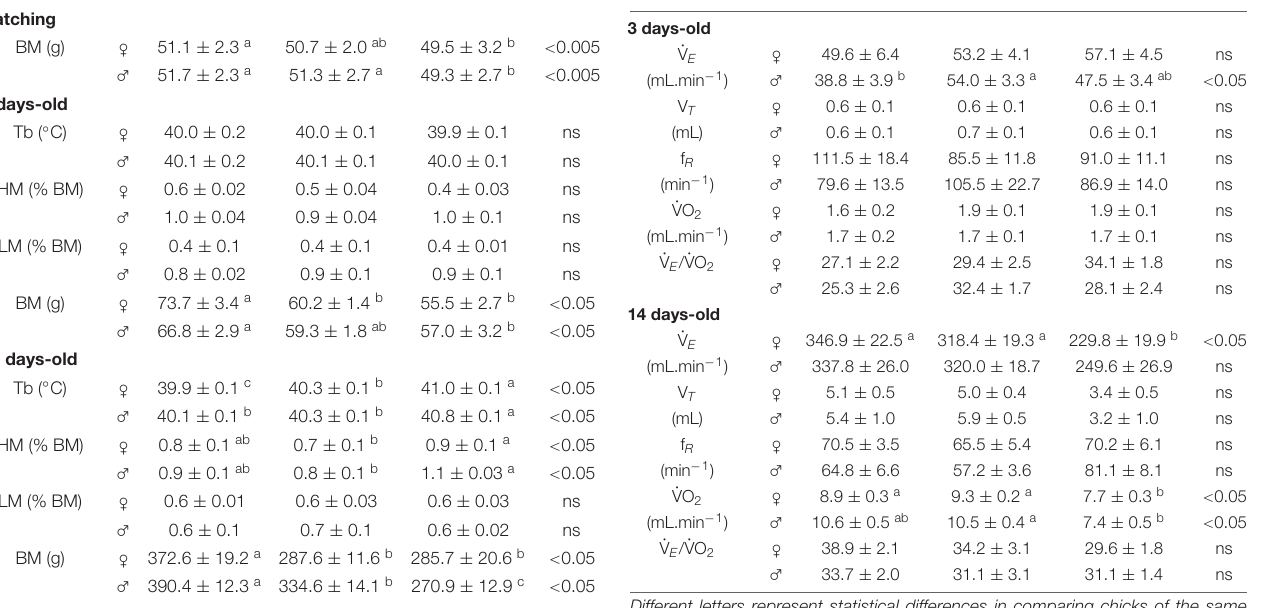
Different letters represent statistical differences in comparing chicks of the same sex and parameter. Significance level (P ≤ 0.05). ns, not significant (P > 0.05). [3d